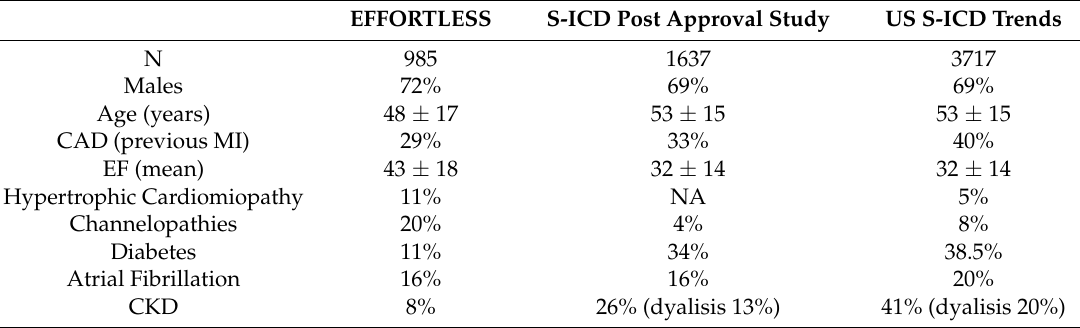
Table 1. S-ICD recipients in early as compared with contemporary real-life registries.